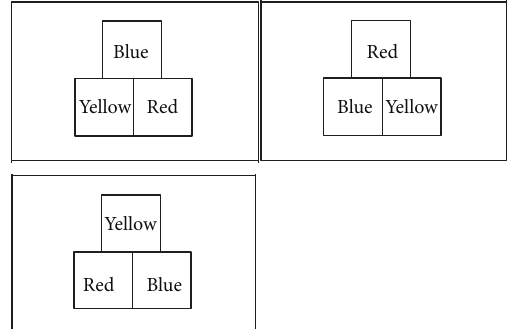
Figure 1: The arrangement of three colored squares that should be remembered and reproduced later after an interference task using three wooden colored cards. One of 3 models was shown to the